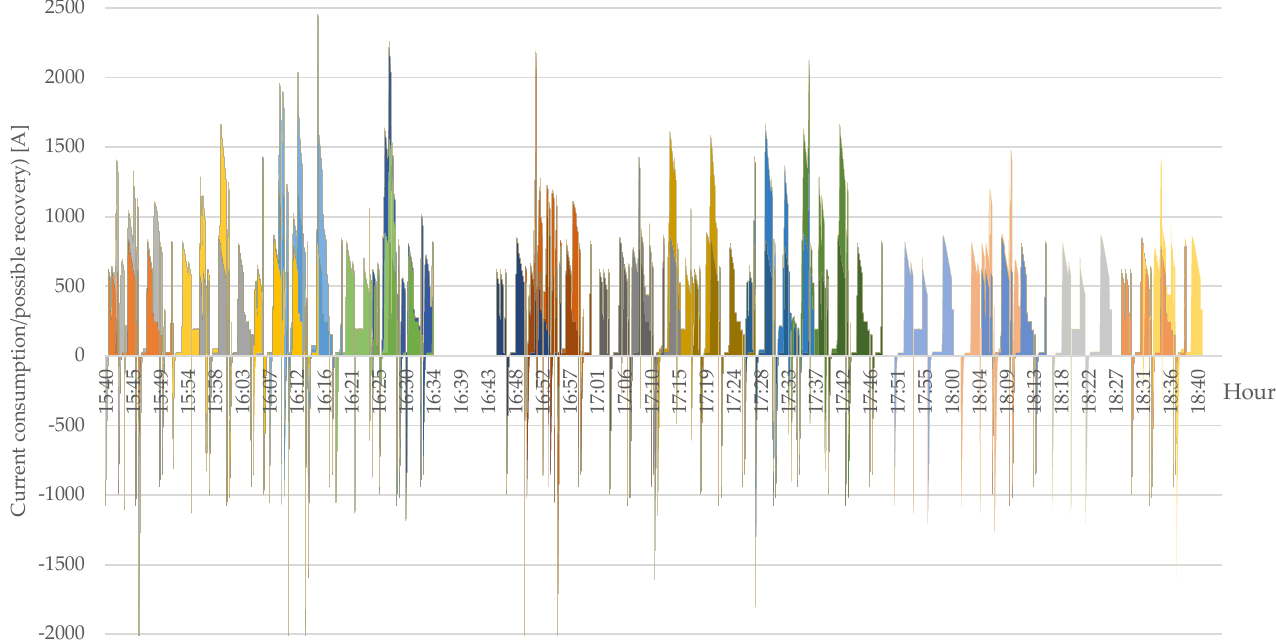
Figure 4. Extract from the results obtained for the timetable simulation in the variant before reconfiguration.